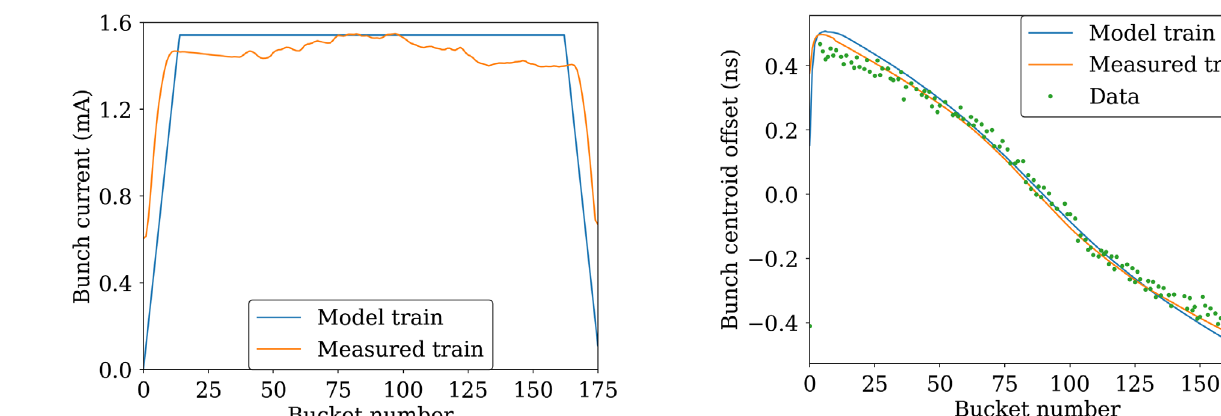
FIG. 1. Bunch-train current profiles used in the reconstruction of the beam transient.